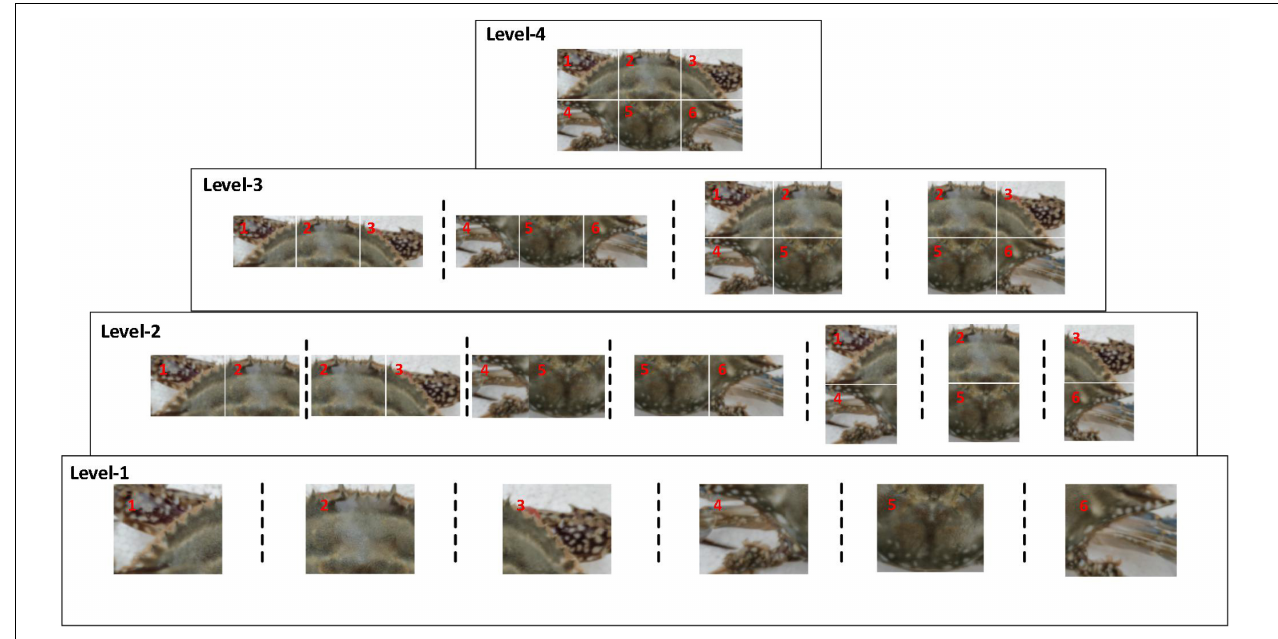
FIGURE 4 | Pyramid-based strategy. There are 18 groups in the four levels, covering the whole P. trituberculatus carapace characteristics locally and